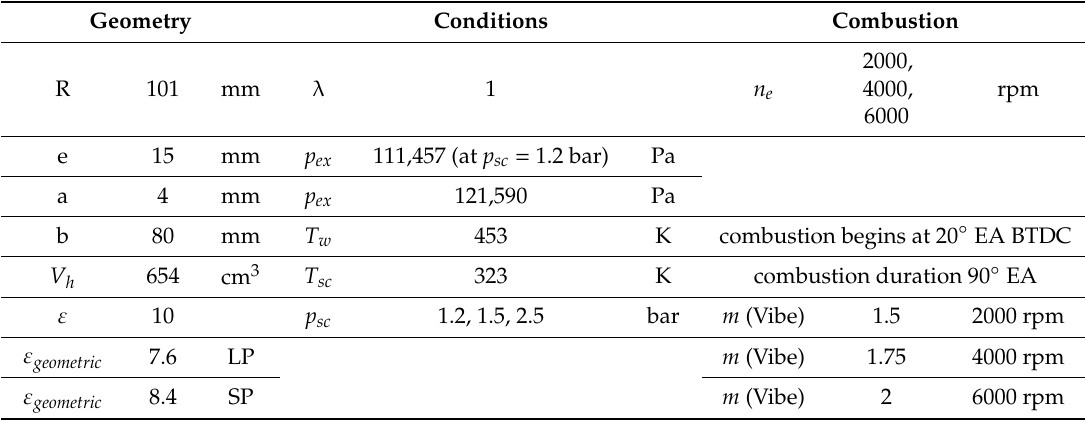
Table 3. The geometric and working condition parameters used in thermodynamic